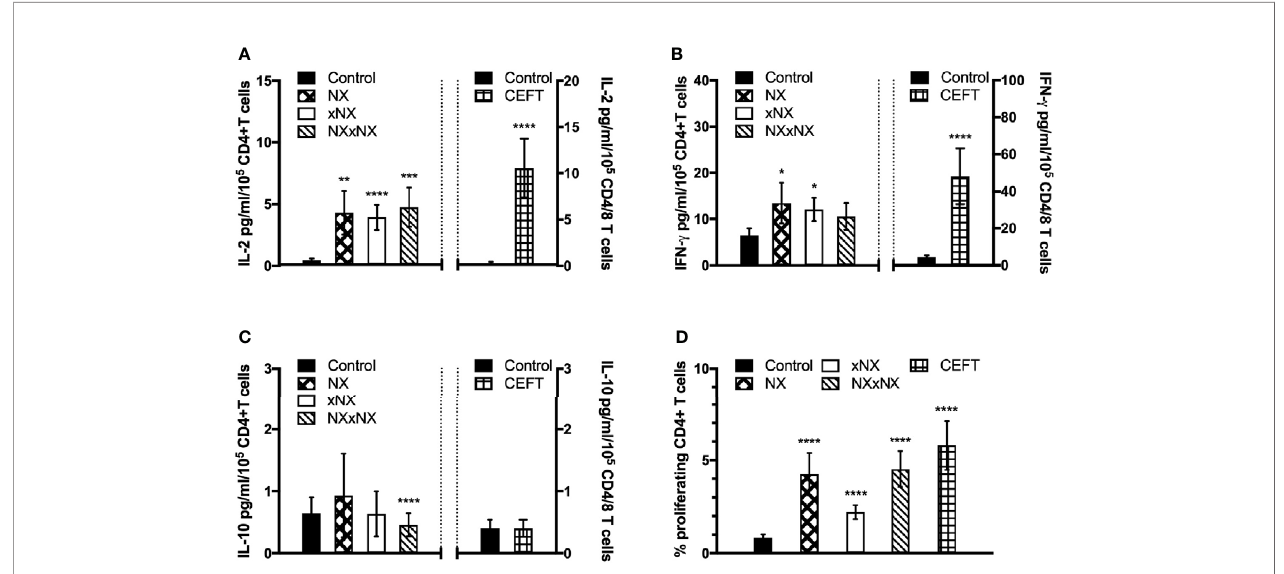
FIGURE 7 | Gluten-speci fi c T cell responses prior to Nexvax2 administration. Gluten peptide-stimulated whole blood CRA (A – C) and CD4+ T cell proliferation measured by 8-day CTV-dye dilution assay before treatment (D) at Visit 5 in 21 patients randomized in the RESET CeD Study. Bars represent the mean and SEM. Wilcoxon signed-rank test was used to compare gluten peptide-stimulated cytokine release versus Control; statistical signi fi cance is indicated by *p < 0.05, **p < 0.01, ***p < 0.001, or ****p <